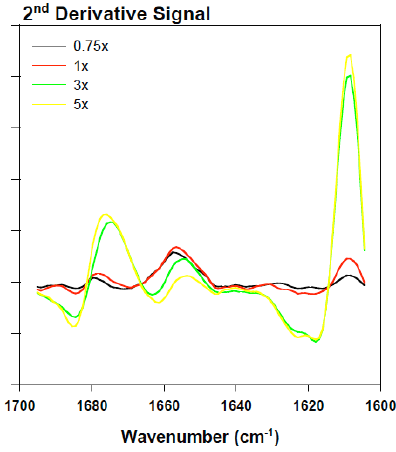
Figure 7. Superimposed inverted BSA second derivative signal in the presence of various rotenone equivalents following a 30-min incubation